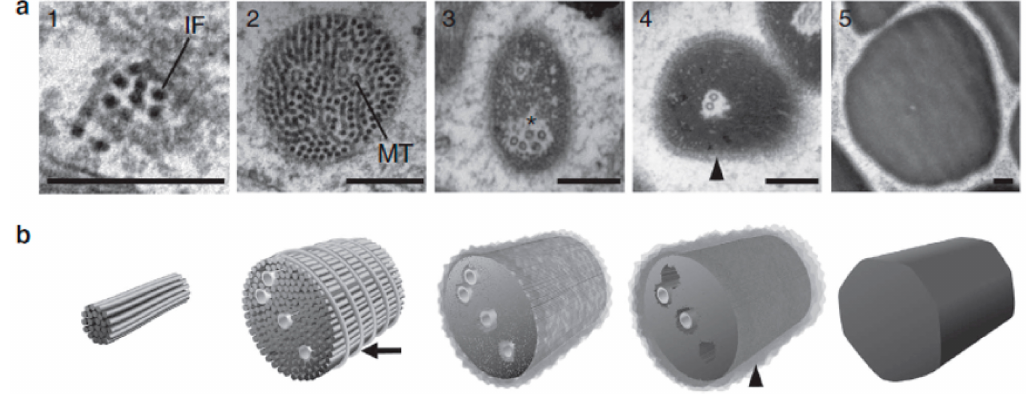
Figure 5. Changes in thread ultrastructure over gland thread cell (GTC) development. ( a ) Transmission electron micrographs (TEM) of thread cross-sections depicting changes in ultrastructure over development. The threads initially only consist of a bundle of intermediate filaments) (IFs) (1), but gradually increase in diameter via the addition of IFs and eventually microtubules (MTs) to the thread (2). The thread becomes more tightly packed with IFs around the MTs (3), until a fluffy rind appears on the thread surface (4). In fully mature thread, IF proteins are further compared, and the MTs and fluffy rind disappear from the thread, with the final product being electron-dense threads (5); ( b ) models illustrating the development of the thread as it matures, showing the transition from a bundle of a few IFs with intermediate MTs, to a fully condensed, mature thread [24].